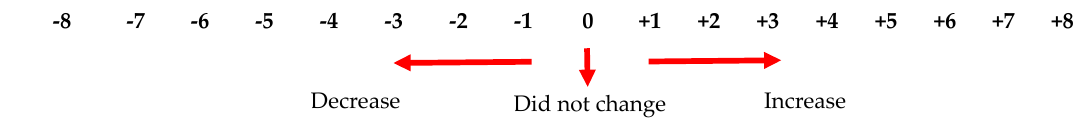
Figure 4. Classification of security level transformation of property rights.